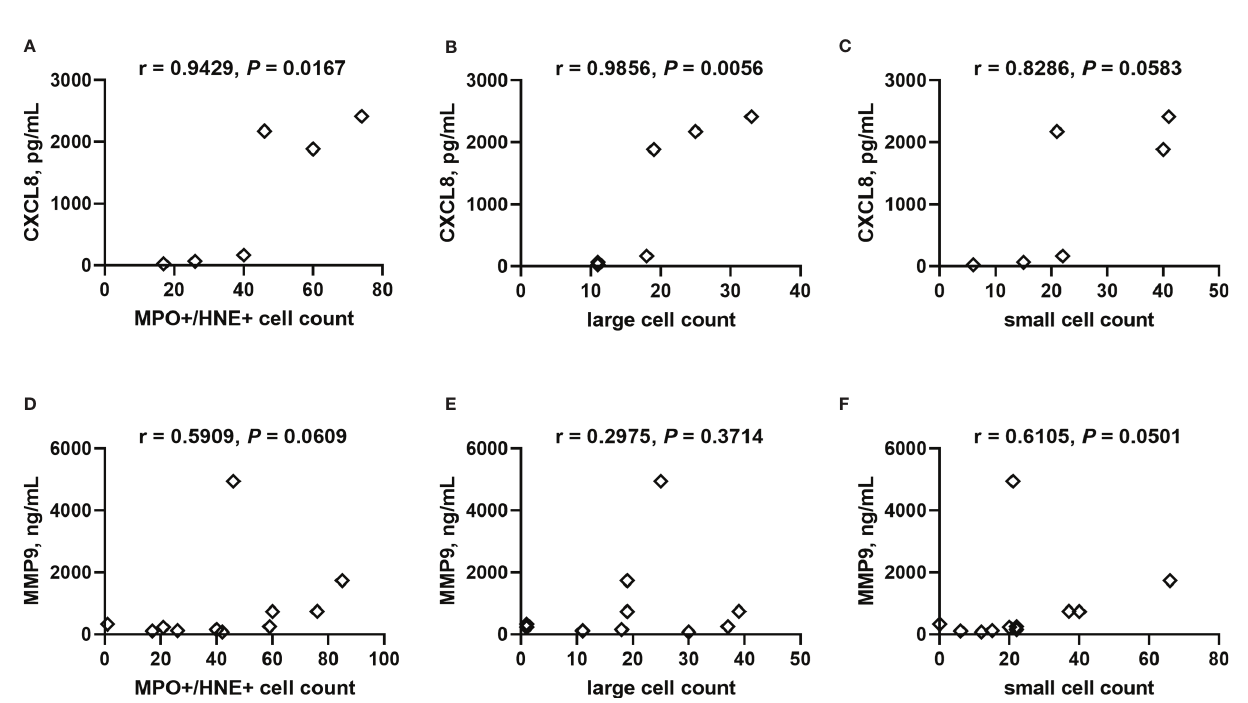
FIGURE 10 | Correlation analysis of CXCL8 and MMP9 with neutrophils in placental tissue. Counts of neutrophils detected in frozen cryosections as (A, D) MPO+ /NE+, and MPO+/NE+ cells strati fi ed by size as (B, E) large: >102 m m 2 , and (C, F) small: <102 m m 2 collectively correlated with placental plasma levels of (A – C) CXCL8 and (D – F) MMP9. Cell counts determined by analysis of immuno fl uorescence of tissues. Statistics by Spearman ’ s correlation test. PM-/HIV-, n = 5; PM+ /HIV-, n = 5; PM-/HIV+, n = 4; PM+/HIV+, n = 4. Groups as de fi ned in Figure 2